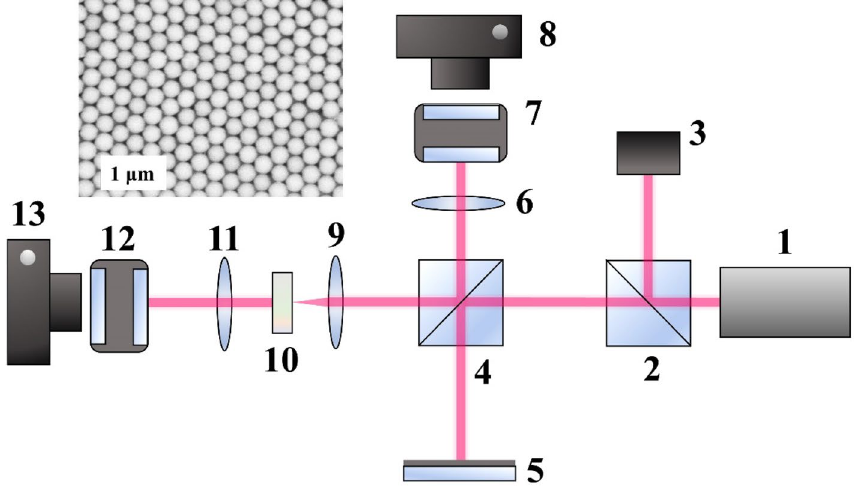
Figure 1. Experimental setup. 1—laser; 2, 4—transparent glass beam splitters with transmission to reflection rate 92:8; 3—the system for electromagnetic radiation parameters control; 5—mirror; 6, 9, 11—focusing systems; 7, 12—Fabry–Perot interferometers; 8, 13—digital cameras; 10—sample. Inset—SEM image of the opal matrix